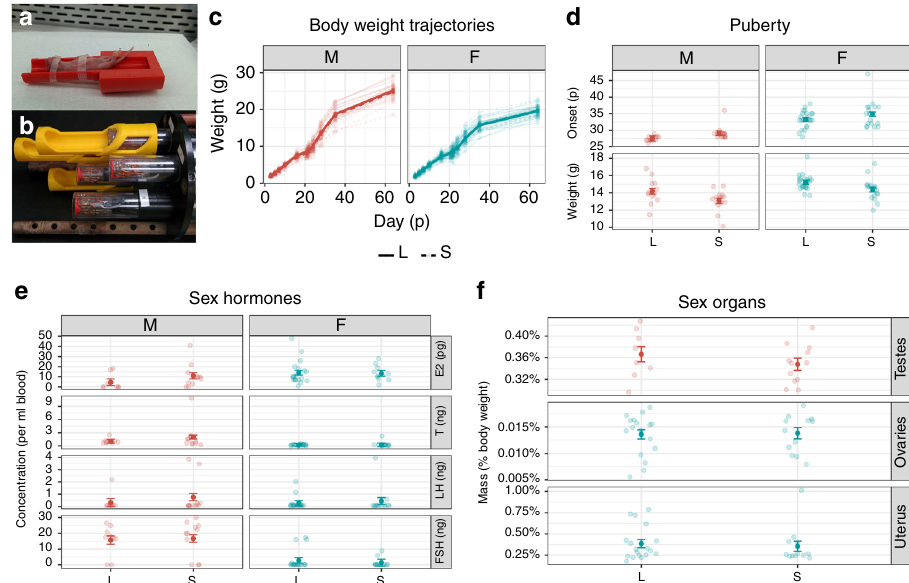
Fig. 1 Scanning apparatus, and scanned mice (S) vs. non-scanned littermates (L) data. a Custom 3D printed holders for neonatal mice. b Up to seven mice at a time were scanned using a saddle coil array. c Body weight was not signi fi cantly different between scanned and unscanned mice ( χ 2 0 : 13, P = 0.94). 2 ¼ There was also no interaction effect of scanning and sex ( χ 2 0 : 097, P = 0.75). Trendlines and bars for standard error were calculated using centered 1 ¼ linear mixed-effect models. d Repeated scanning did not have a signi fi cant effect on puberty onset ( F 3 ; 64 ¼ 24 : 67, t 64 = 1.56, P = 0.12) but did have a signi fi cant effect on weight at puberty ( F 10 : 67, t 2 : 43, P = 0.02). However, neither measure had a sex-scanning interaction ( t 0 : 045, 3 ; 64 ¼ 64 ¼ (cid:2) 64 ¼ (cid:2) P = 0.96 and t : 451, P = 0.65). e Scanning did not have a signi fi cant effect on the levels of sex hormones estradiol ( F : 11, t = 0.16, P = 0.87), 48 64 ¼ 0 3 ; 48 ¼ 1 testosterone ( F 4 : 17, t 48 = 0.32, P = 0.15), LH ( F 0 : 68, t 48 = 1.03, P = 0.31), FSH ( F 14 : 19, t 48 = 0.28, P = 0.78). f Organ weight of testes 3 ; 48 ¼ 3 ; 48 ¼ 3 ; 48 ¼ ( F 1 ; 18 ¼ 1 : 05, t 18 ¼ (cid:2) 1 : 0, P = 0.32), ovaries ( F 1 ; 28 ¼ 0 : 03, t 28 = 0.17, P = 0.87), and uteri ( F 1 ; 28 ¼ 0 : 17, t 28 ¼ (cid:2) 0 : 41, P = 0.69) were not affected by repeated scanning. Means and bars for standard error for d , e , and f were estimated using linear